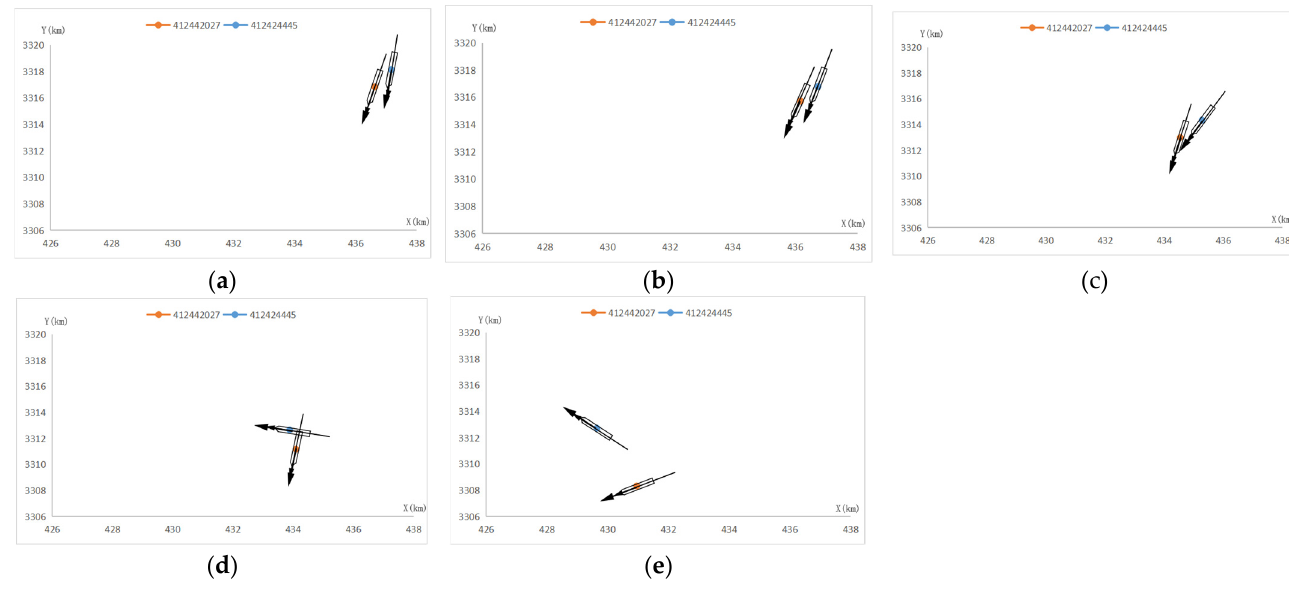
Figure 8. Position of two ships: ( a ) the two ships at 19:37; ( b ) the two ships at 19:41; ( c ) the two ships at 19:52; ( d ) the two ships at 20:00; ( e ) the two ships at